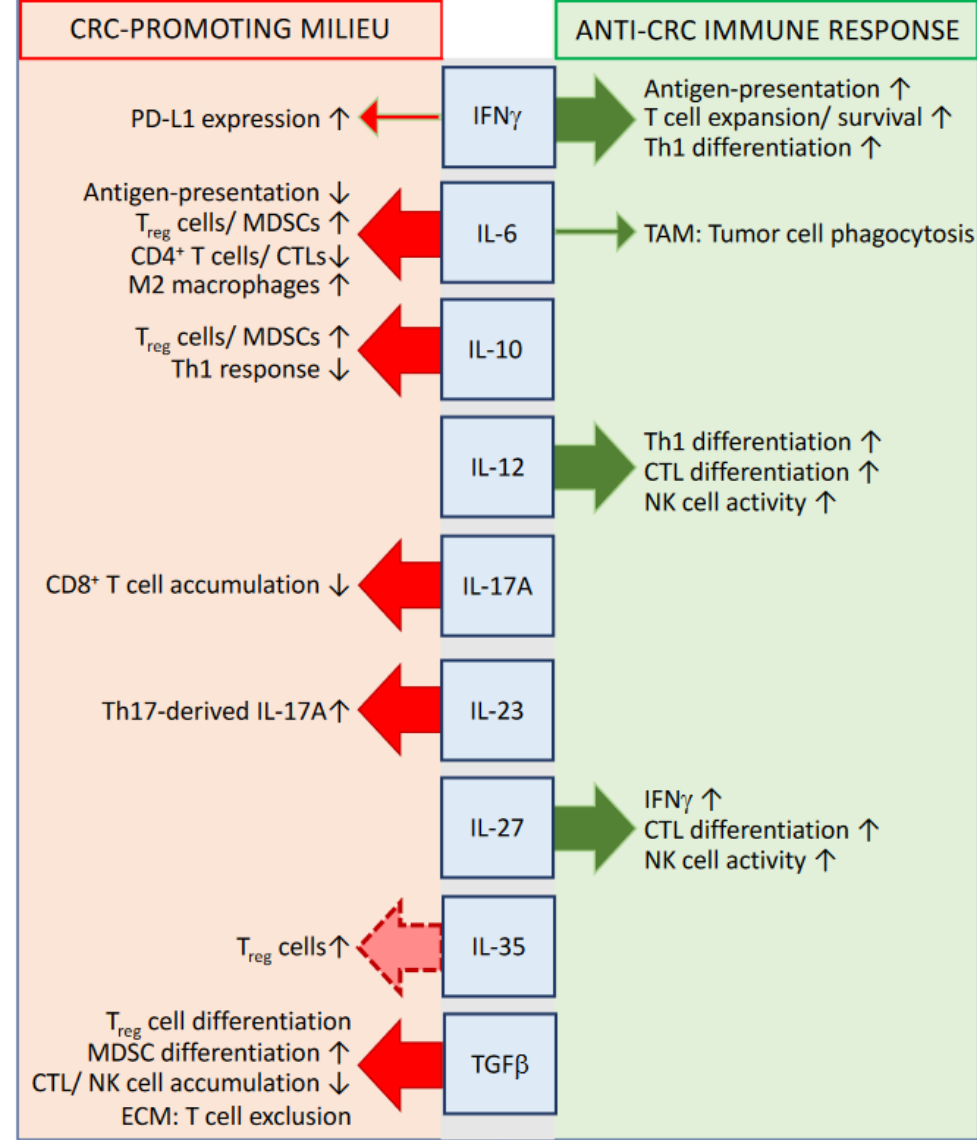
Figure 2. Cytokines of described relevance for the immune system-mediated control of CRC. Abbrevi- ations: PD-L1 = programmed death ligand 1; TAM = tumor-associated macrophages; CTL = cytotoxic T lymphocytes; MDSC = myeloid-derived suppressor cell; ECM = extracellular matrix; ↑ = increased; ↓ = decreased.